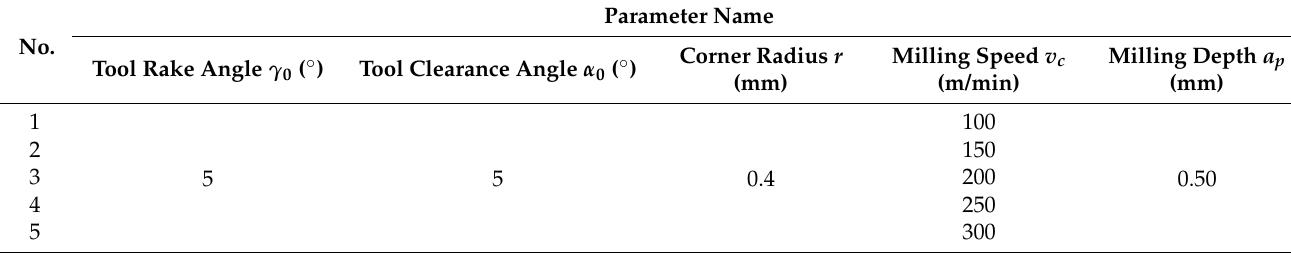
Table 8. Single-factor analysis scheme for different milling